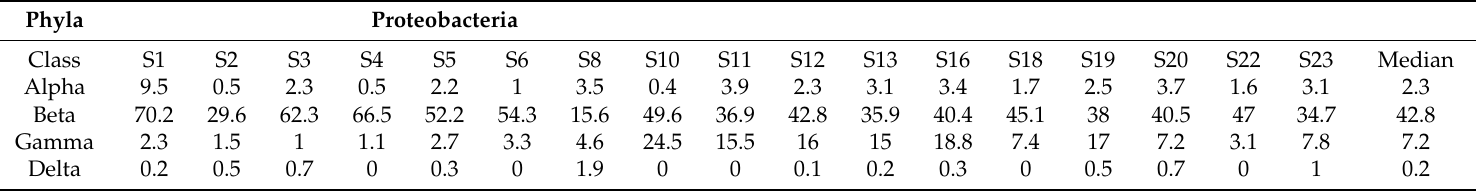
Table 3. Relative abundances (%) of di ff erent classes of Proteobacteria for stations (S) 1 through 23 along the Cauvery